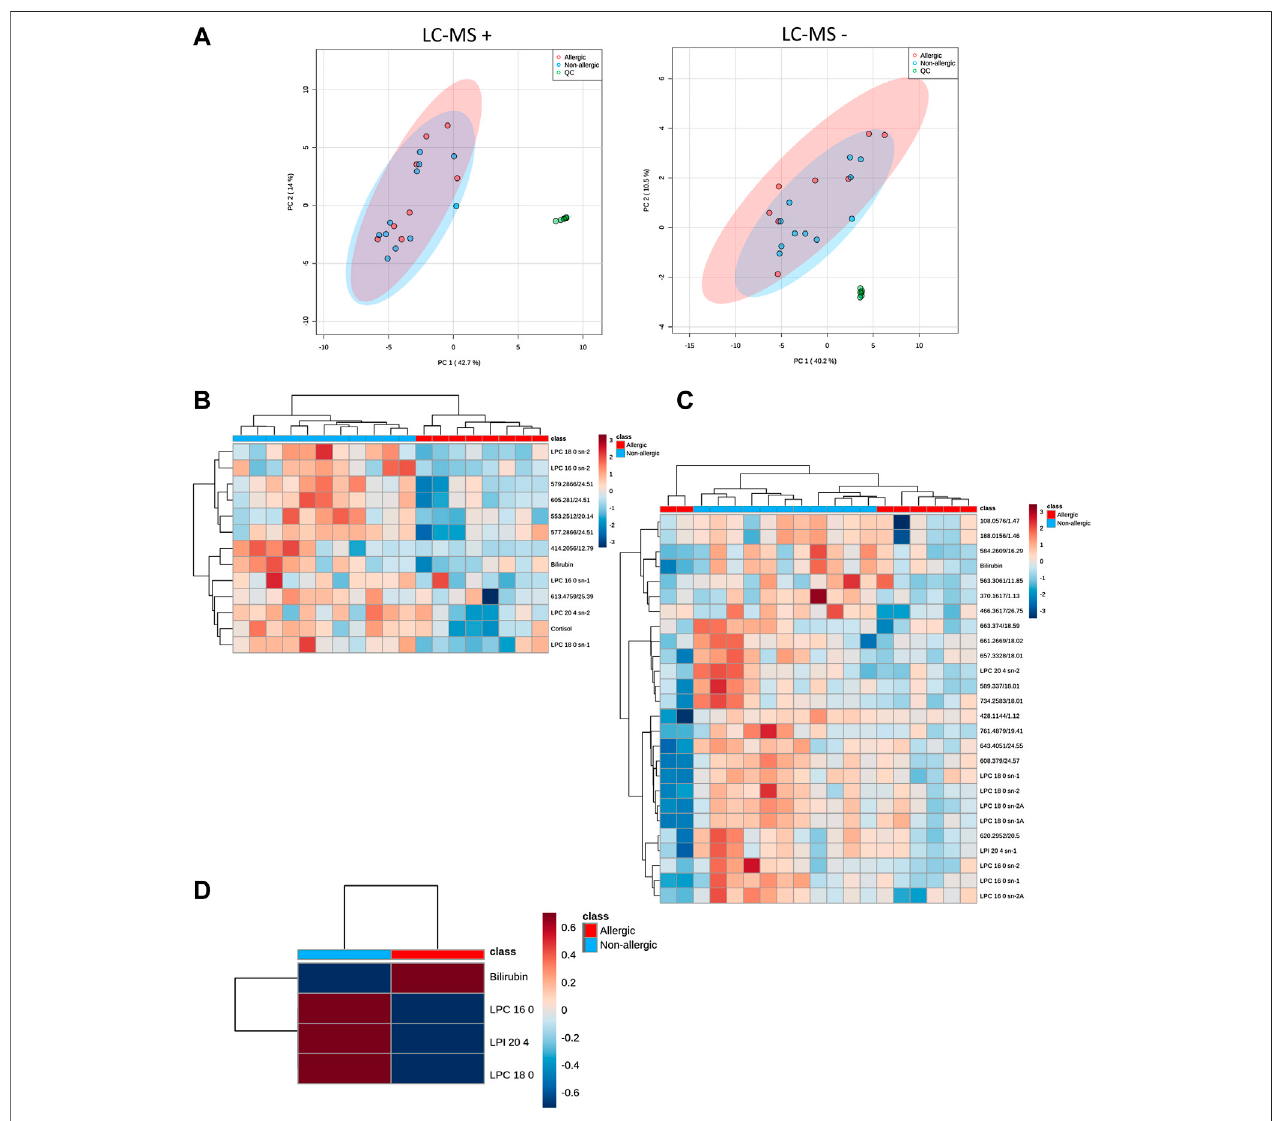
FIGURE2 |(A). Unsupervized PCA for QCinjections ( C ; green dot), allergic patientswith CRSwNP ( C ;red dot) and non-allergic patients with CRSwNP ( C ; blue dot) models showing the quality of the data for LC-MS. Con fi dence regions for each group were set at 95% and are depicted with the corresponding color group. Data were centered scaled and Log transformed. (B,C). Signi fi cant signals were depicted on aheatmap using hierarchical clustering ofthe samples(represented in columns) and metabolites (in rows) for ESI + and ESI − , respectively. Red cells represent higher levels of the speci fi c metabolite in that sample, whereas blue cells represent lower levels. Samples and metabolites are clustered according to their similarity. Mann-Whitney U test with a Benjamini-Hochberg correction was used to detect statistical signi fi cance ( p < 0.05). Unknown features are represented by “ Mass@Retention Time. ” (C). Heatmaps of signi fi cant plasma metabolomics signals using hierarchicalclusteringanalysisoftheexperimentalsamplesLC-MSpositivepolarity.MannWhitney U testwasusedtodetectstatisticalsigni fi cance( p < 0.05). (D). Target metabolites analyzed by LC-QqQ-MS in nasal polyps were represented in a heatmap using hierarchical clustering of the samples (represented in columns) and metabolites (in rows) showing group